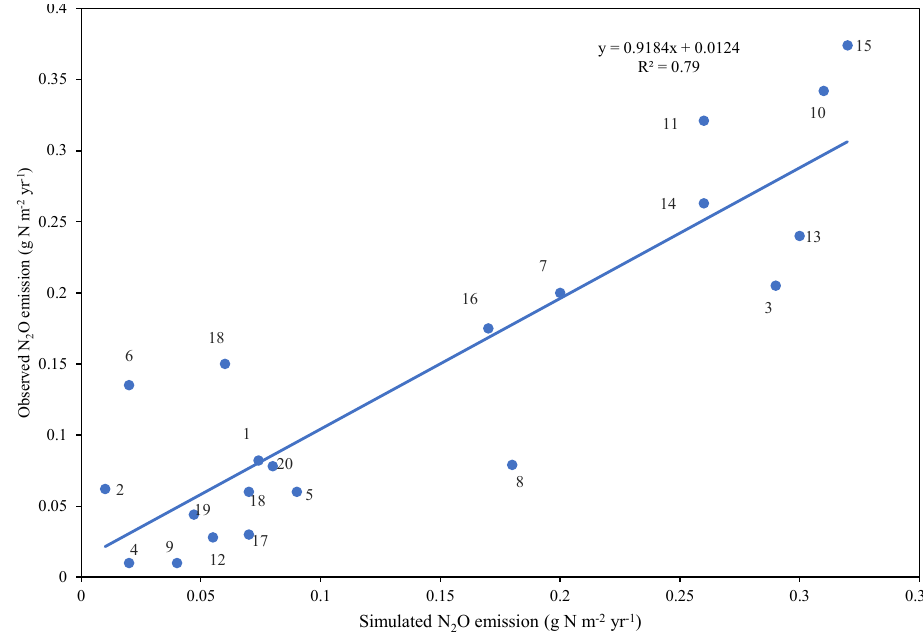
Figure 3. The comparison of the DLEM-simulated N 2 O emissions with field observations. All sites are described in the Supplement (Ta- ble